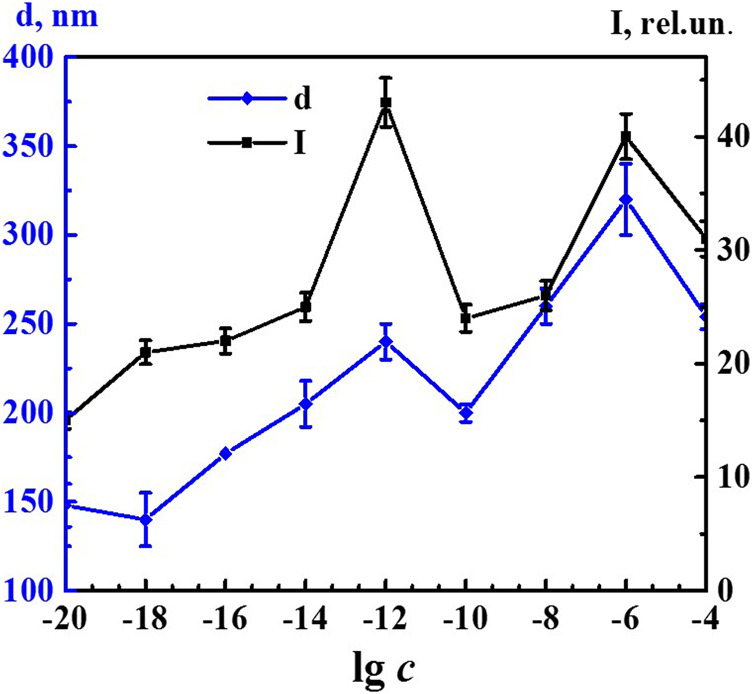
Dependence of particle size (d) and fluorescence intensity (λ
ex225 nm, λ
em340 nm) (I) on concentrations (c/M) of 4-AP. Measurements were performed at 25 ± 0.1°C. Data presented as the mean value ±standard deviation.